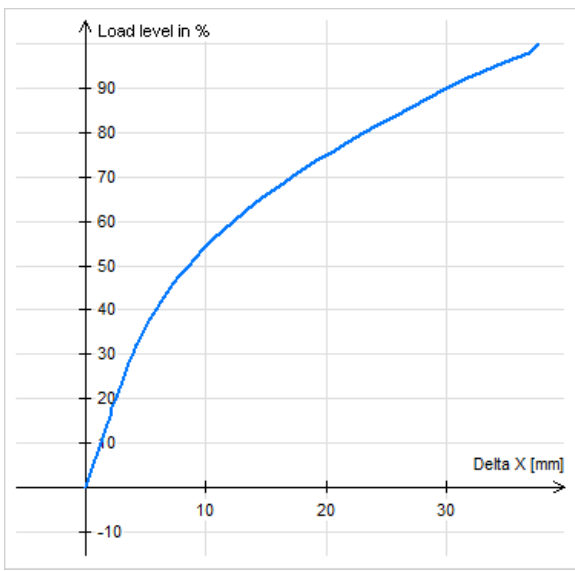
Figure 13. Capacity curve of the model with flexible beams.